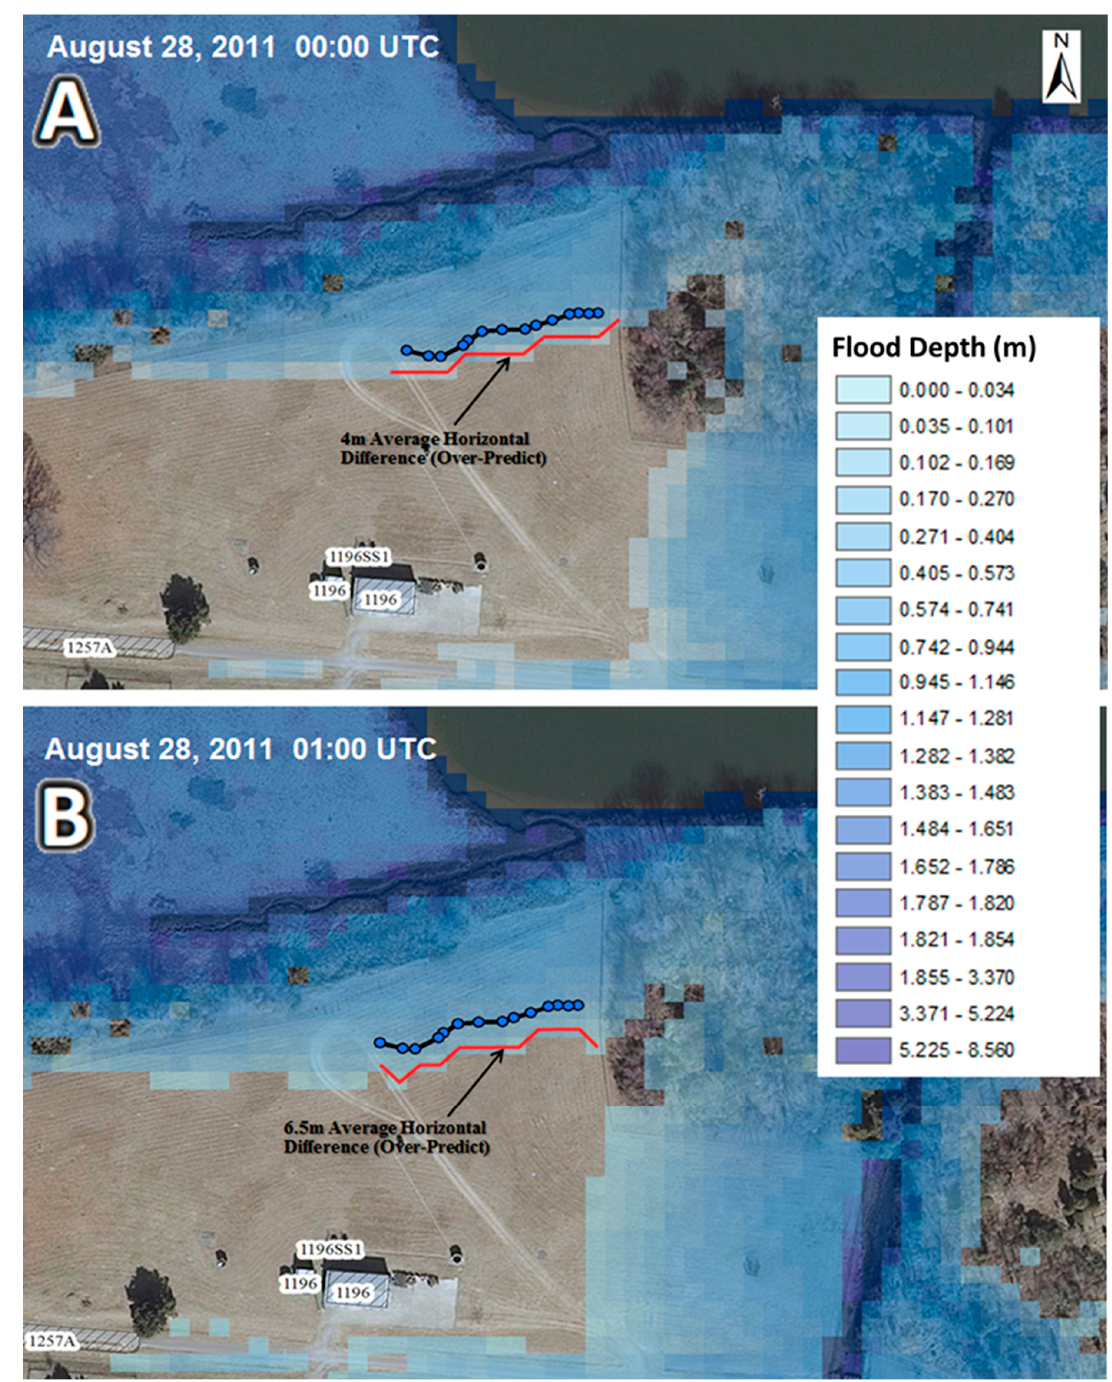
Figure 3. Comparison of GPS maximum flood extent observations (depicted as blue dots) in Hampton, VA, following debris lines remaining after Hurricane Irene 2011, used to geospatially verify model performance at ( A ) 00:00 UTC and ( B ) 01:00 UTC on 28 August 2011. GPS data collected by volunteers effectively illustrate the challenge with temporal matching for model comparison.